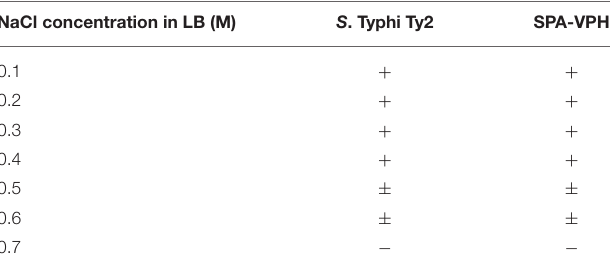
TABLE 2 | Vi slide-agglutination reactions of Salmonella enterica serovar Typhi Ty2 and SPA-VPH grown in the presence of NaCl with varied concentrations.